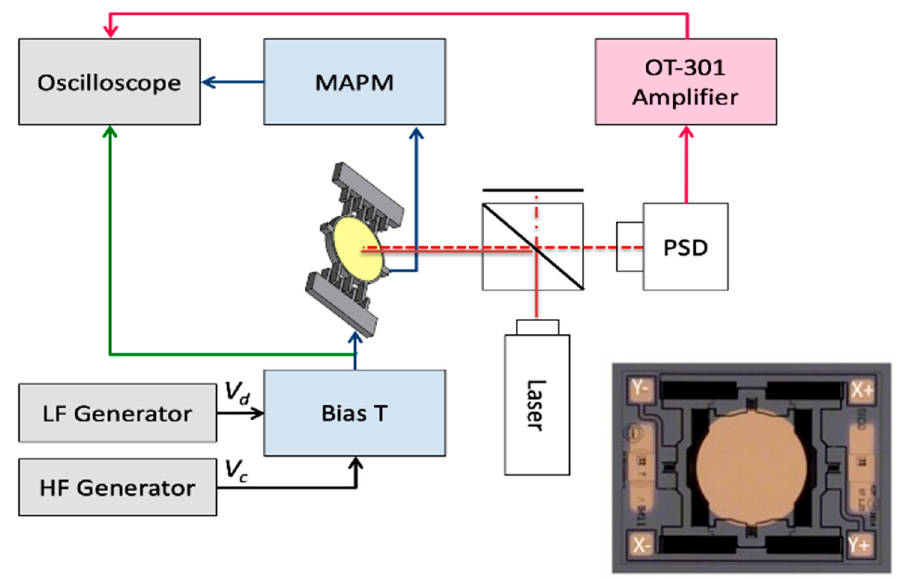
Figure 1. Block diagram of the MAPM experimental setup showing the HF carrier Vc and LF drive Vd combined and sent to one combdrive (Y+) to drive the mirror. To verify operation and calibrate the MAPM, the mirror position is also measured by a PSD. A beam splitter is used to minimize the space between the mirror and PSD. The insert shows the commercial, gimbaled 2D micromirror used in experimental verifications. A voltage applied to the electrode marked Y+ makes the mirror rotate clockwise about the vertical axis, while Y − gives counterclockwise rotation. The same applies for X+ and X − on the horizontal axis.